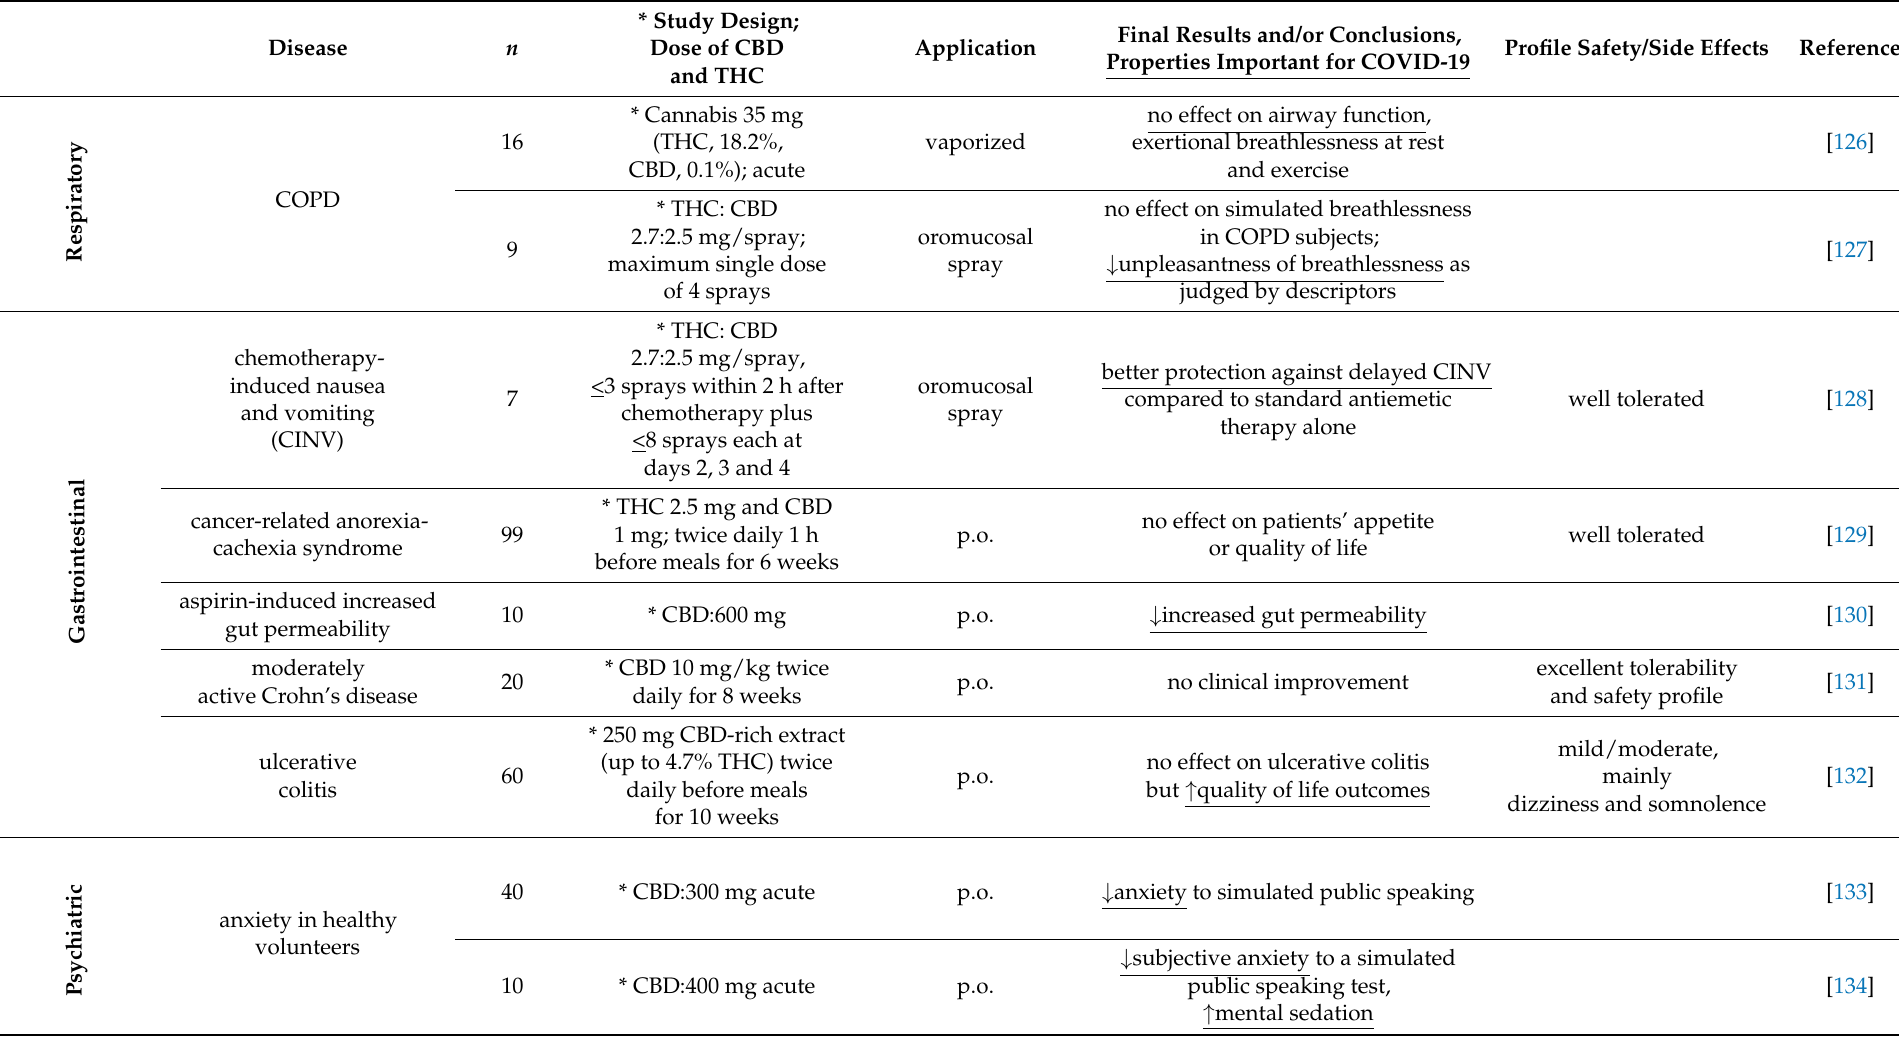
Table 2. Efficacy and safety of cannabidiol in clinical